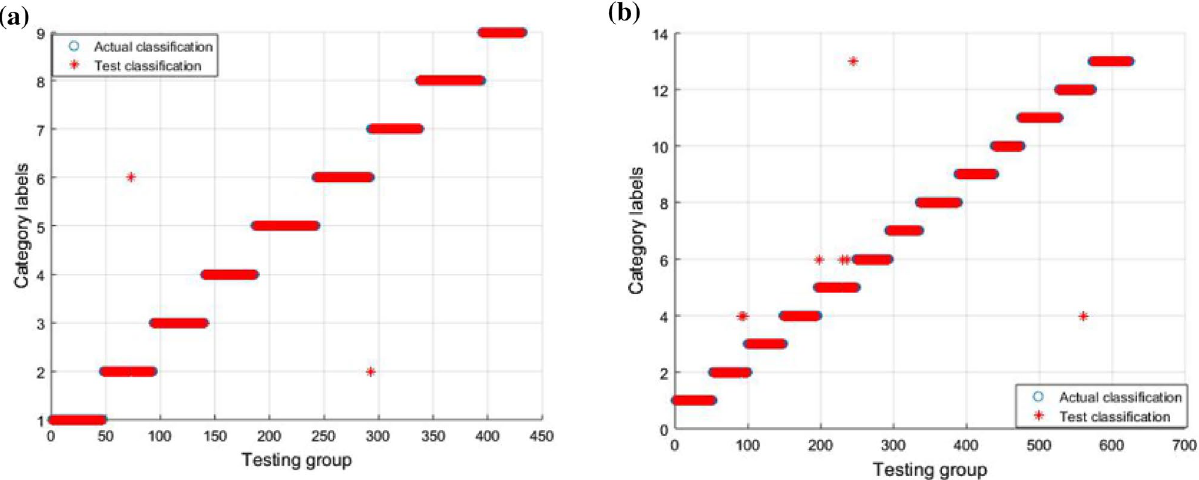
Figure 10. Fault classification result in PSO-SVM: ( a ) classification result for Case 1; ( b ) classification result for Case 2.